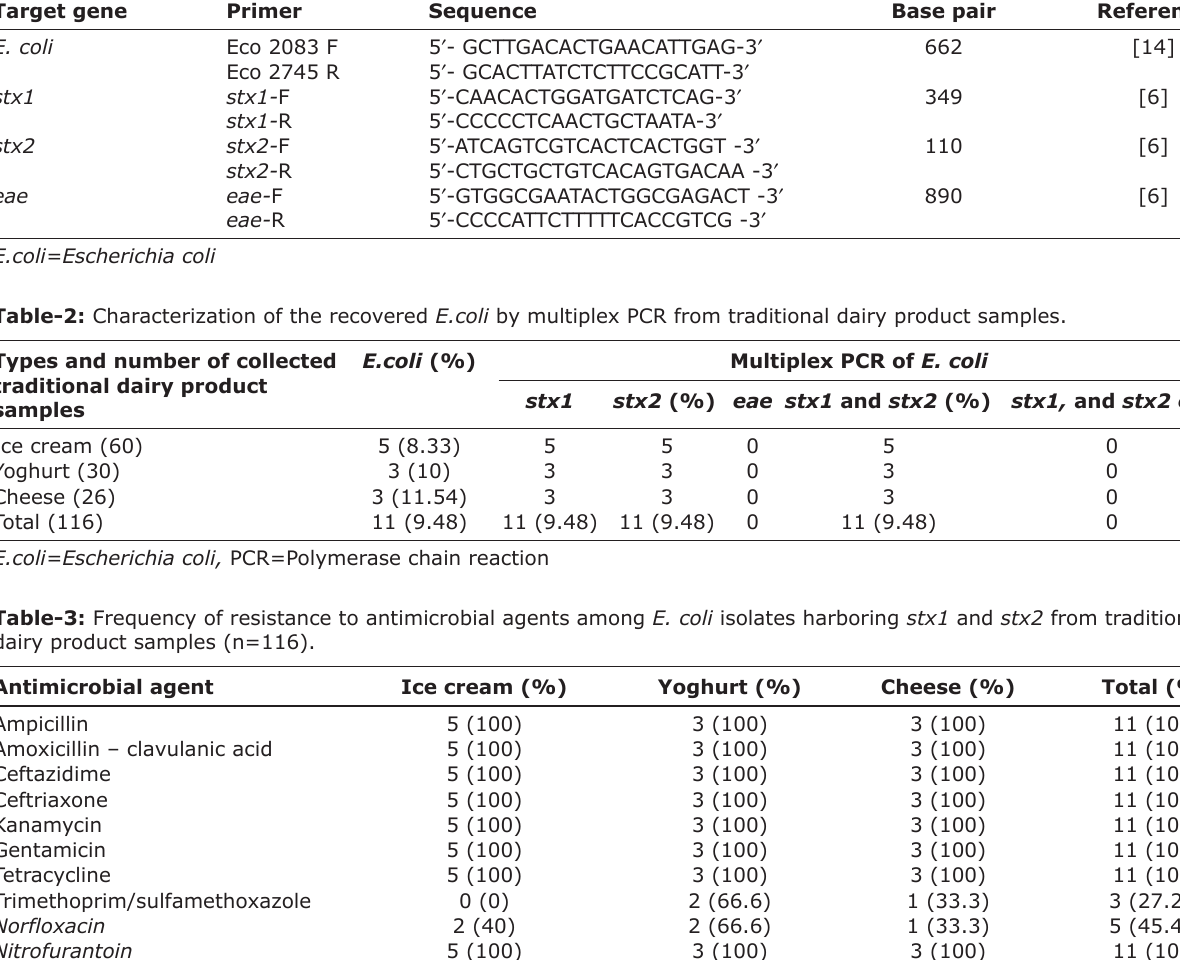
Table-1: Primers used for polymerase chain reaction identification of E. coli , stx1 , stx2, and eae genes.